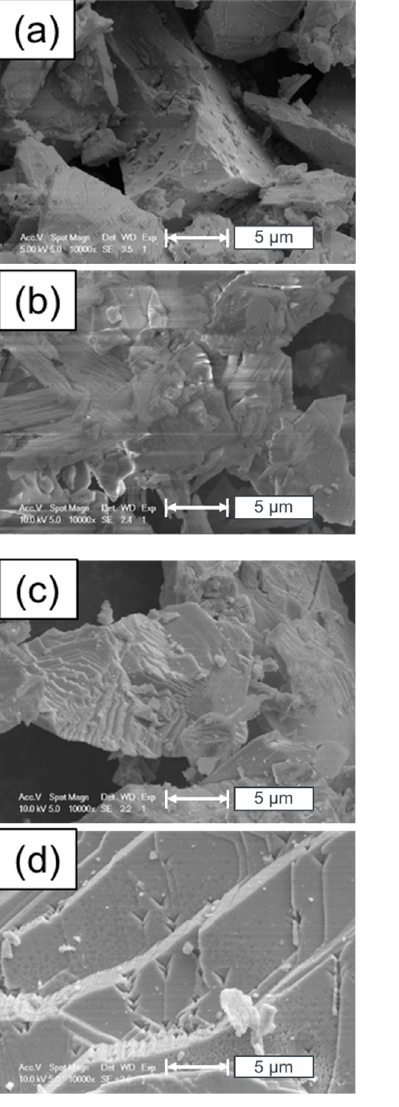
Figure 9. Surface of CdTe 250 powder shown by secondary electron images. ( a ) Initial, untreated powder; ( b ) “Solar cell-like activation” deposits CdCl 2 ; ( c ) “solar cell-like etching” forms steps on Table 1. Initially untreated powder after 20 d of leaching in pH4-solution. ( b1 ) “Activated” powder after 20 days of leaching; ( c1 ) “Etched” powder after 20 d of leaching; ( d1 ) “Activated and etched” powder after 20 d of leaching; ( a2 ) Originally untreated powder after 274 d of leaching; ( b2 ) “Activated” powder after 274 d of leaching. ( c2 ) “Etched” powder after 274 d of leaching. ( d2 ) “Activated and etched” powder after 274 d.